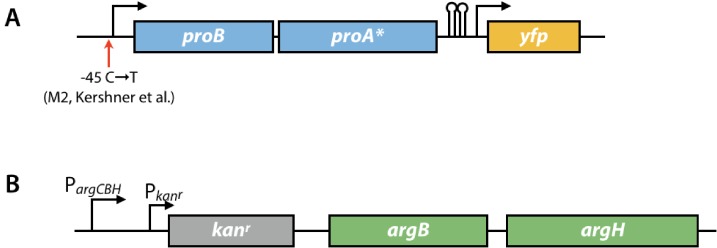
Genome modifications in the parental AM187 strain.(A) Modifications to the proBA operon. proA*; A1148→C proA (changes Glu383 to Ala); M2, a −45 C→T promoter mutation that increases expression of the operon more than 4-fold (Kershner et al., 2016). (B) Modifications to the argCBH operon. argC was replaced with a gene encoding kanamycin resistance in the Keio strain created by Baba et al. (2006).